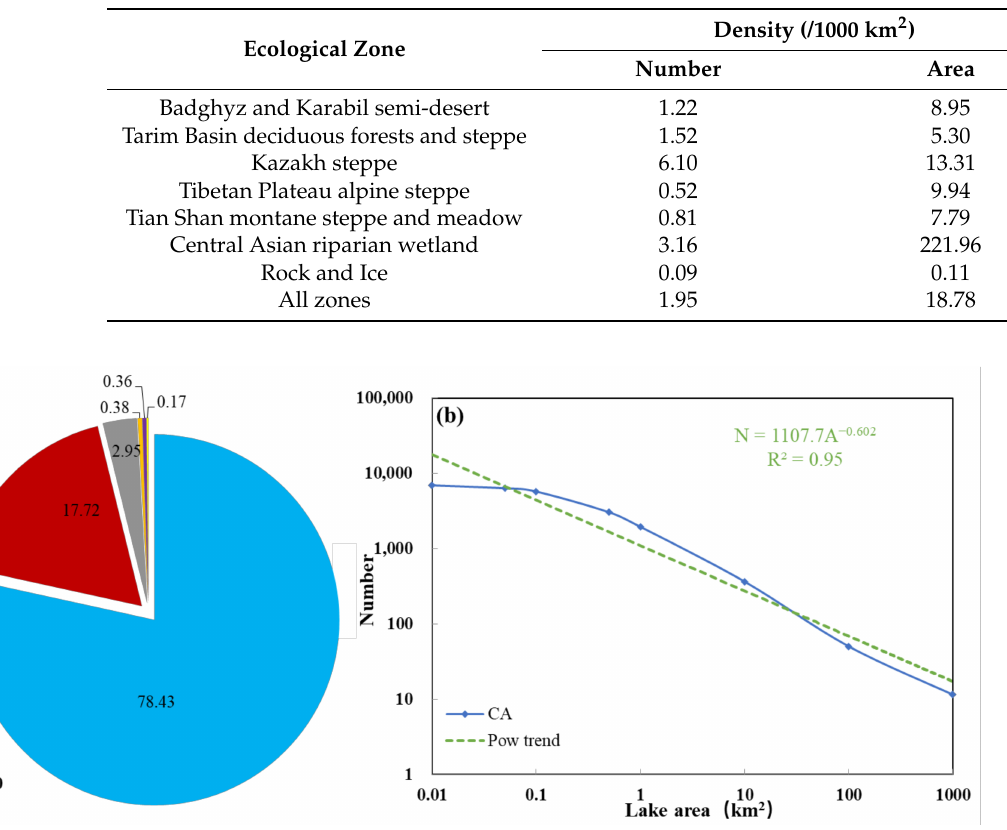
Figure 3. Power-law frequency distribution of lake size in Central